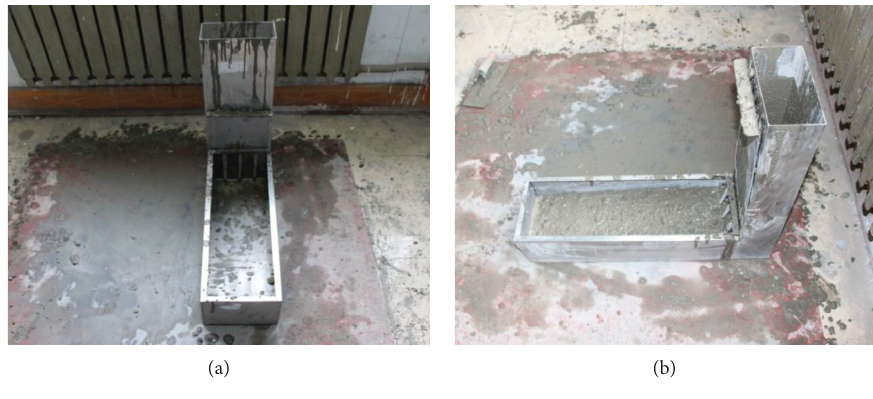
Figure 6: V-funnel